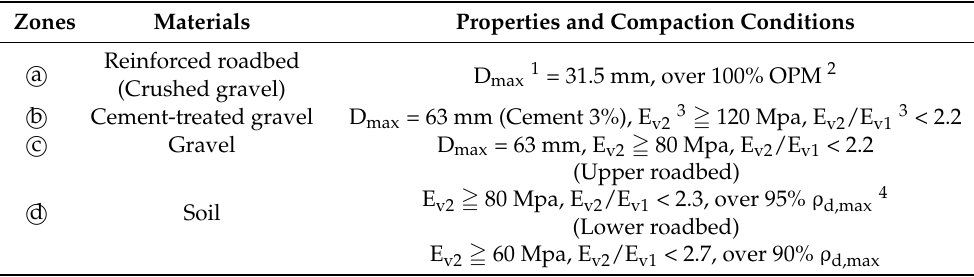
Figure 4. Backfill materials of transition zone. Table 4. Properties and compaction conditions for backfill materials.